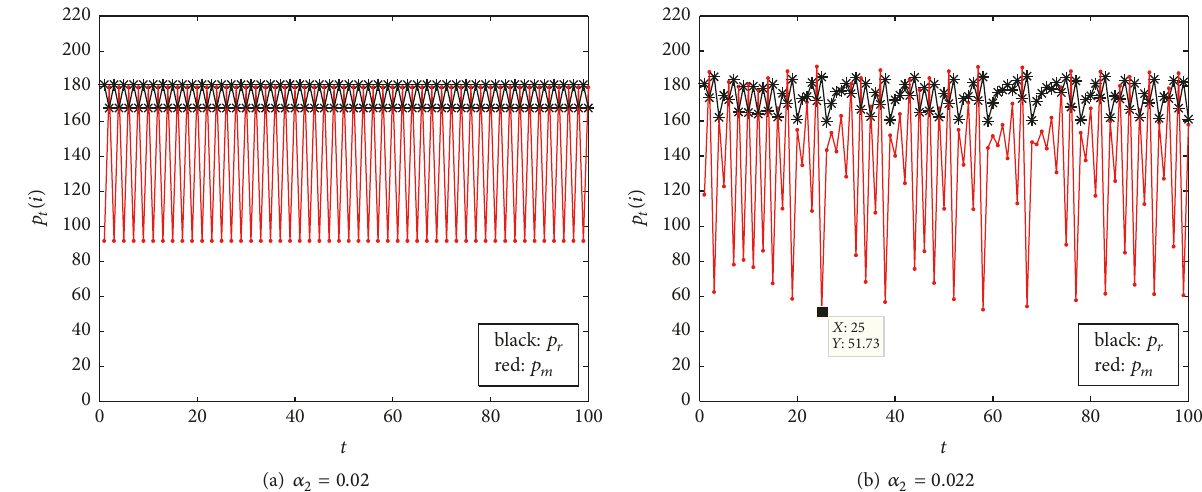
Figure 5: The prices wave plot of system (15) with change of time when 𝛼 1 = 0.005.